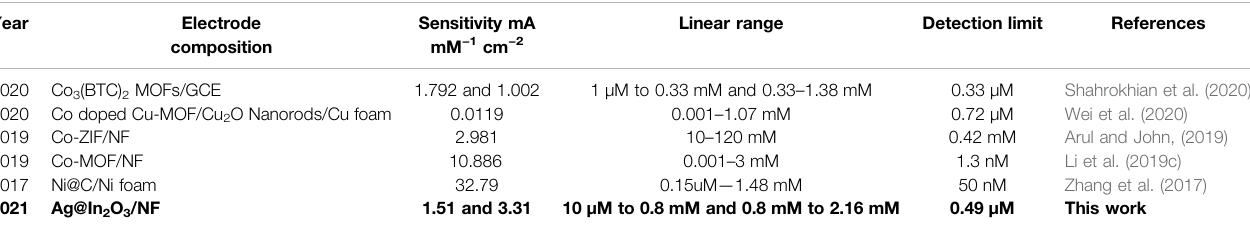
TABLE 1 | Comparison of modi fi ed electrode with other metal oxides based electrochemical sensors for glucose